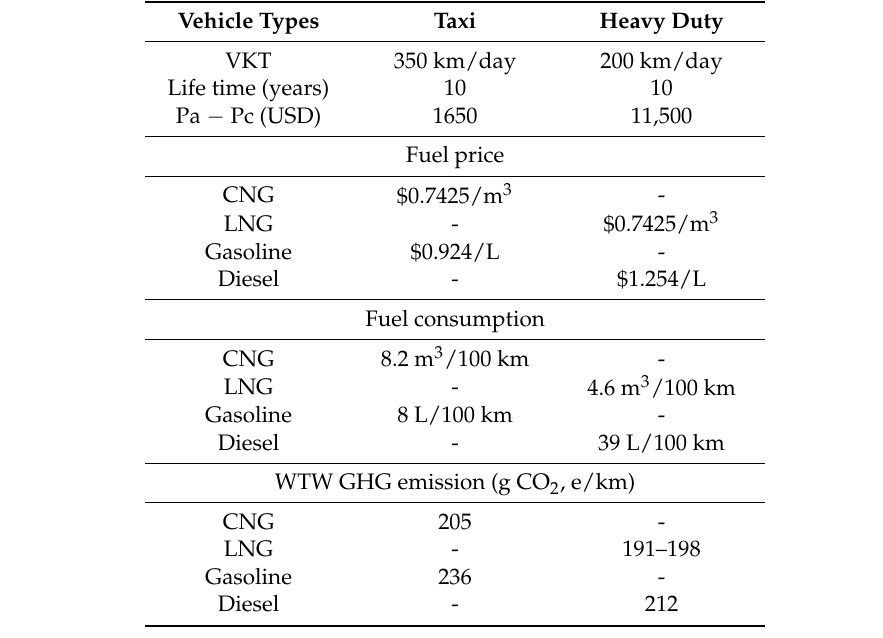
Table 13. Assumptions for CNGVs and LNGVs